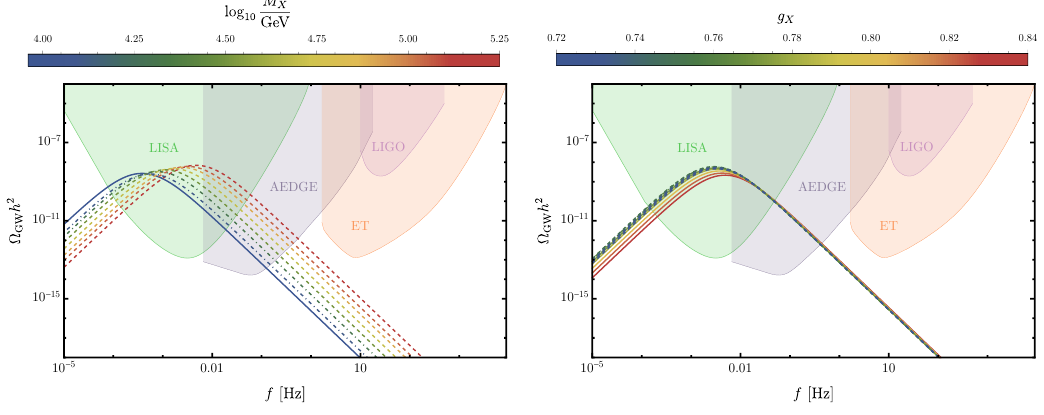
= 0 . 76 X = 100 TeV and varying value X